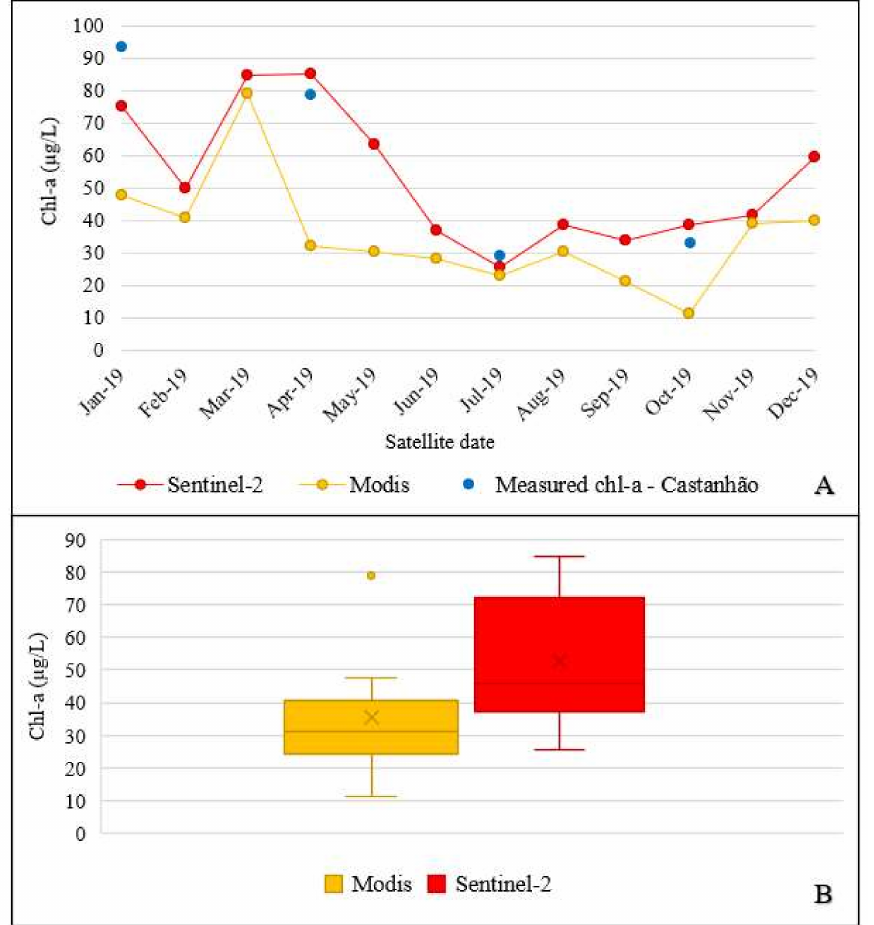
Figure 5. Comparison between the chl-a estimated by the Sentinel-2 satellite and by MODIS satellite, for the Castanh ã o reservoir, for the months of 2019. ( A ) shows the temporal variation jointly with the quarterly field measurements. ( B ) displays the boxplot with the distribution of chl-a values estimated respectively by Sentinel-2 and